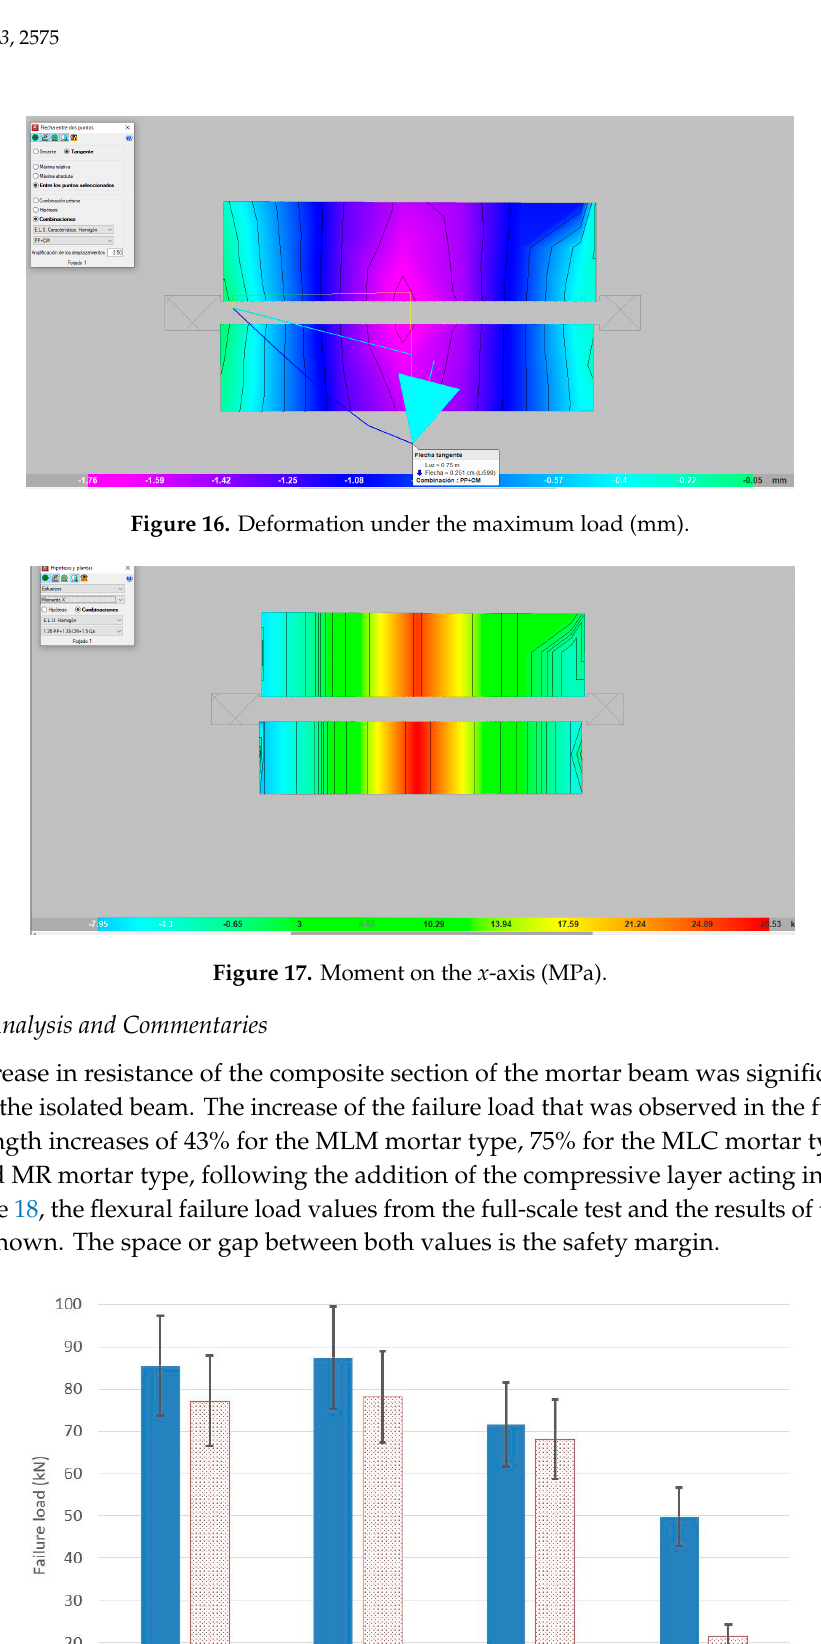
Figure 18. Full-scale test results vs. analytical results.